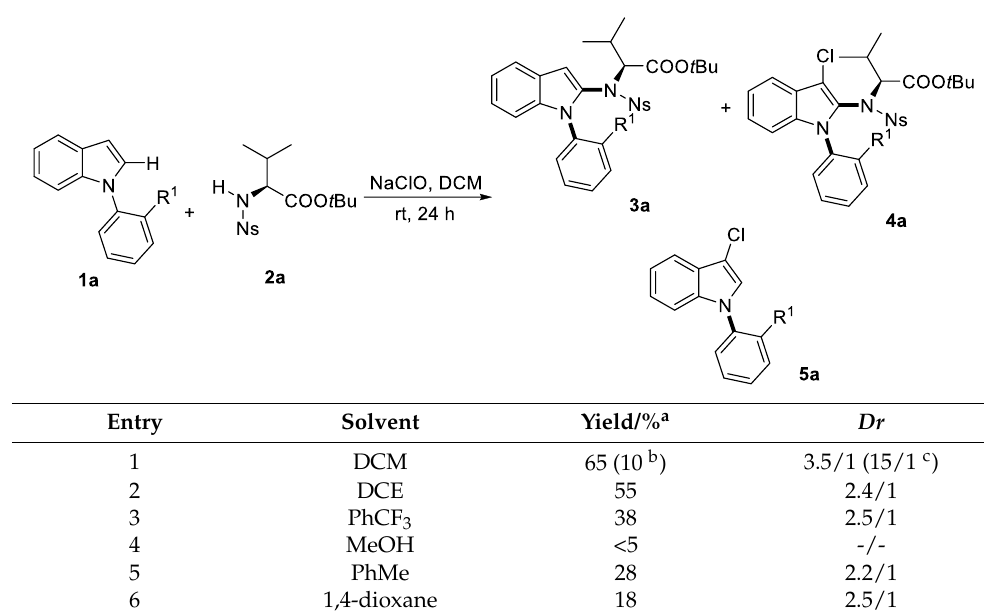
Table 1. Solvent screening for indole C – N axially chiral construction.